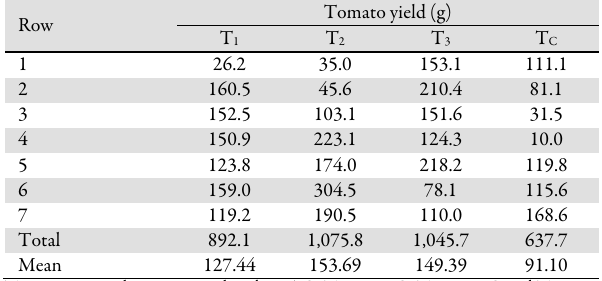
Table 5. Tomato yield from the different magnetized water treatments